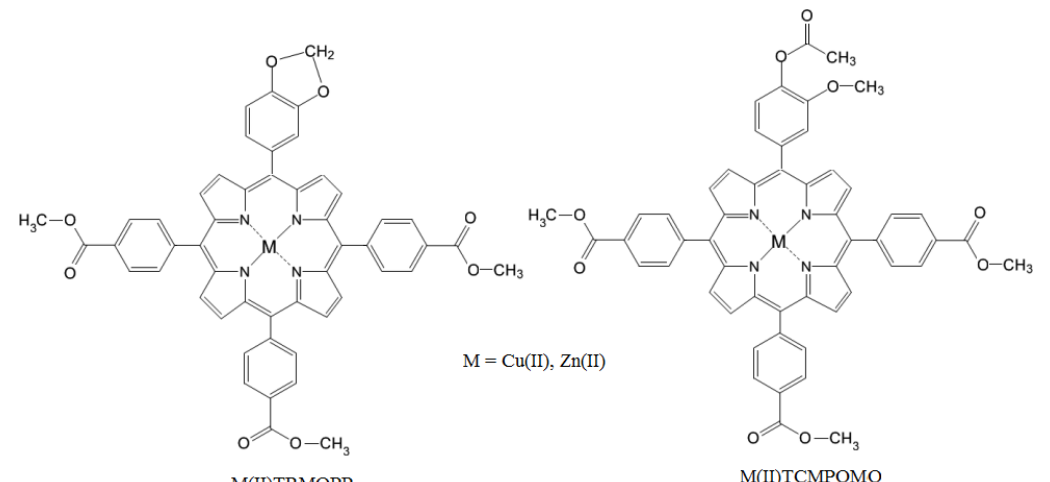
Figure 1. General structures of the unsymmetrical mesoporphyrinic